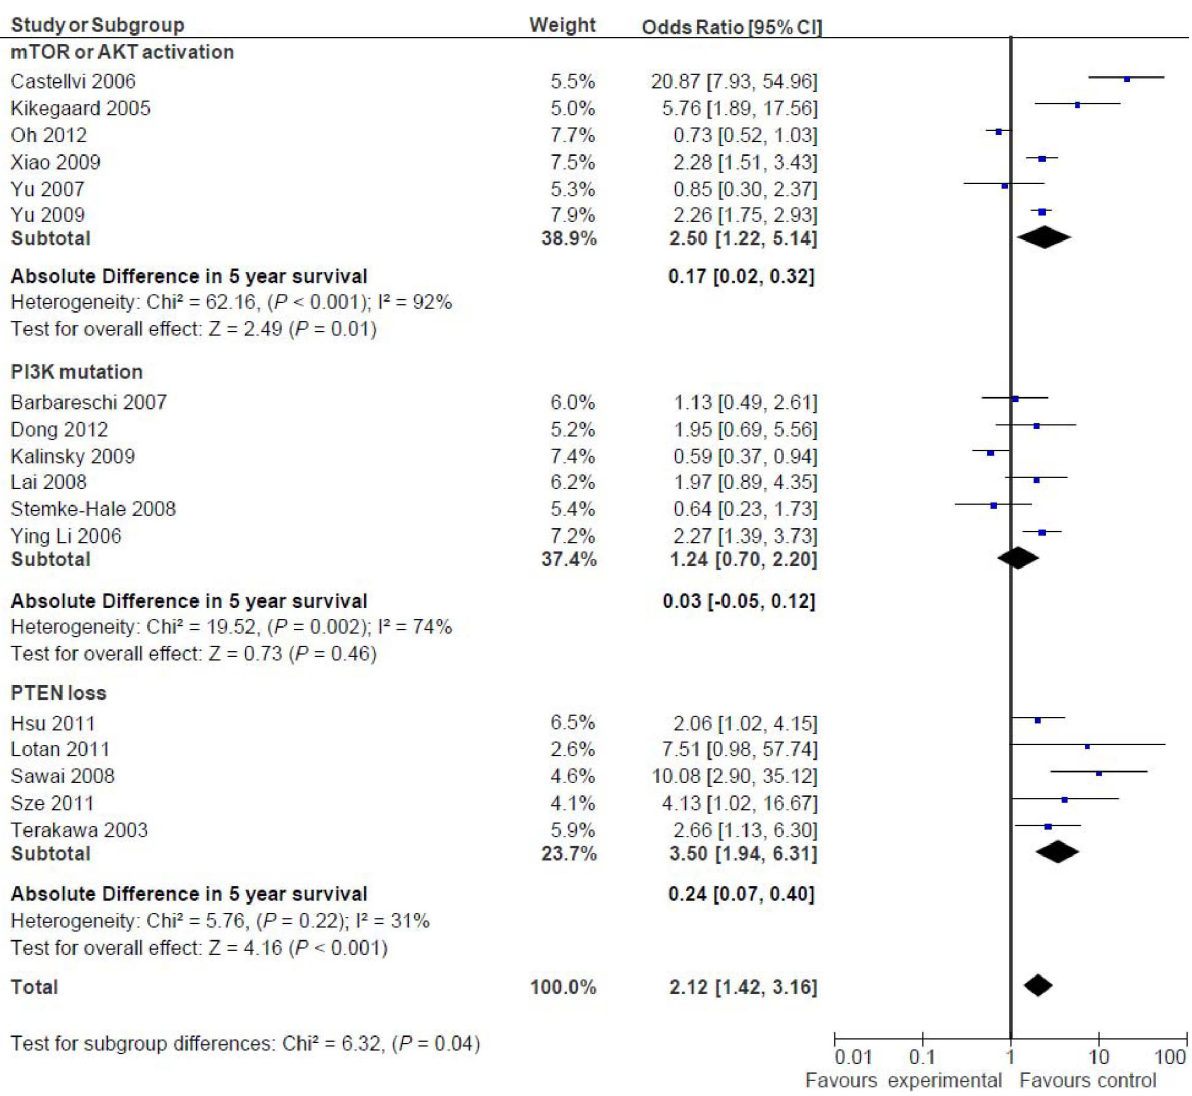
Figure S1 Flow diagram of literature search. Figure S2 PRISMA flowchart using MeSH terms.